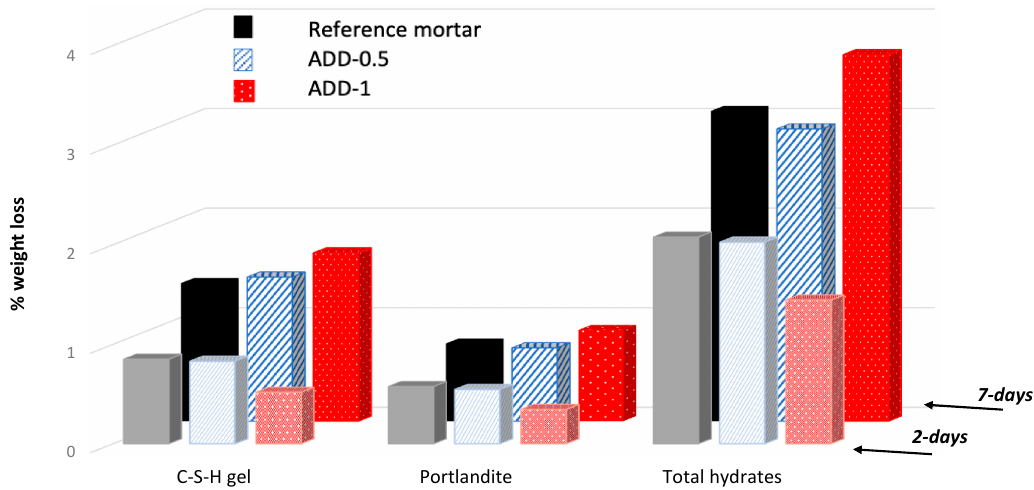
Figure 11. Estimation of the content of hydrated phases after 2 and 7 days of curing in high-humidity conditions (98% relative humidity).